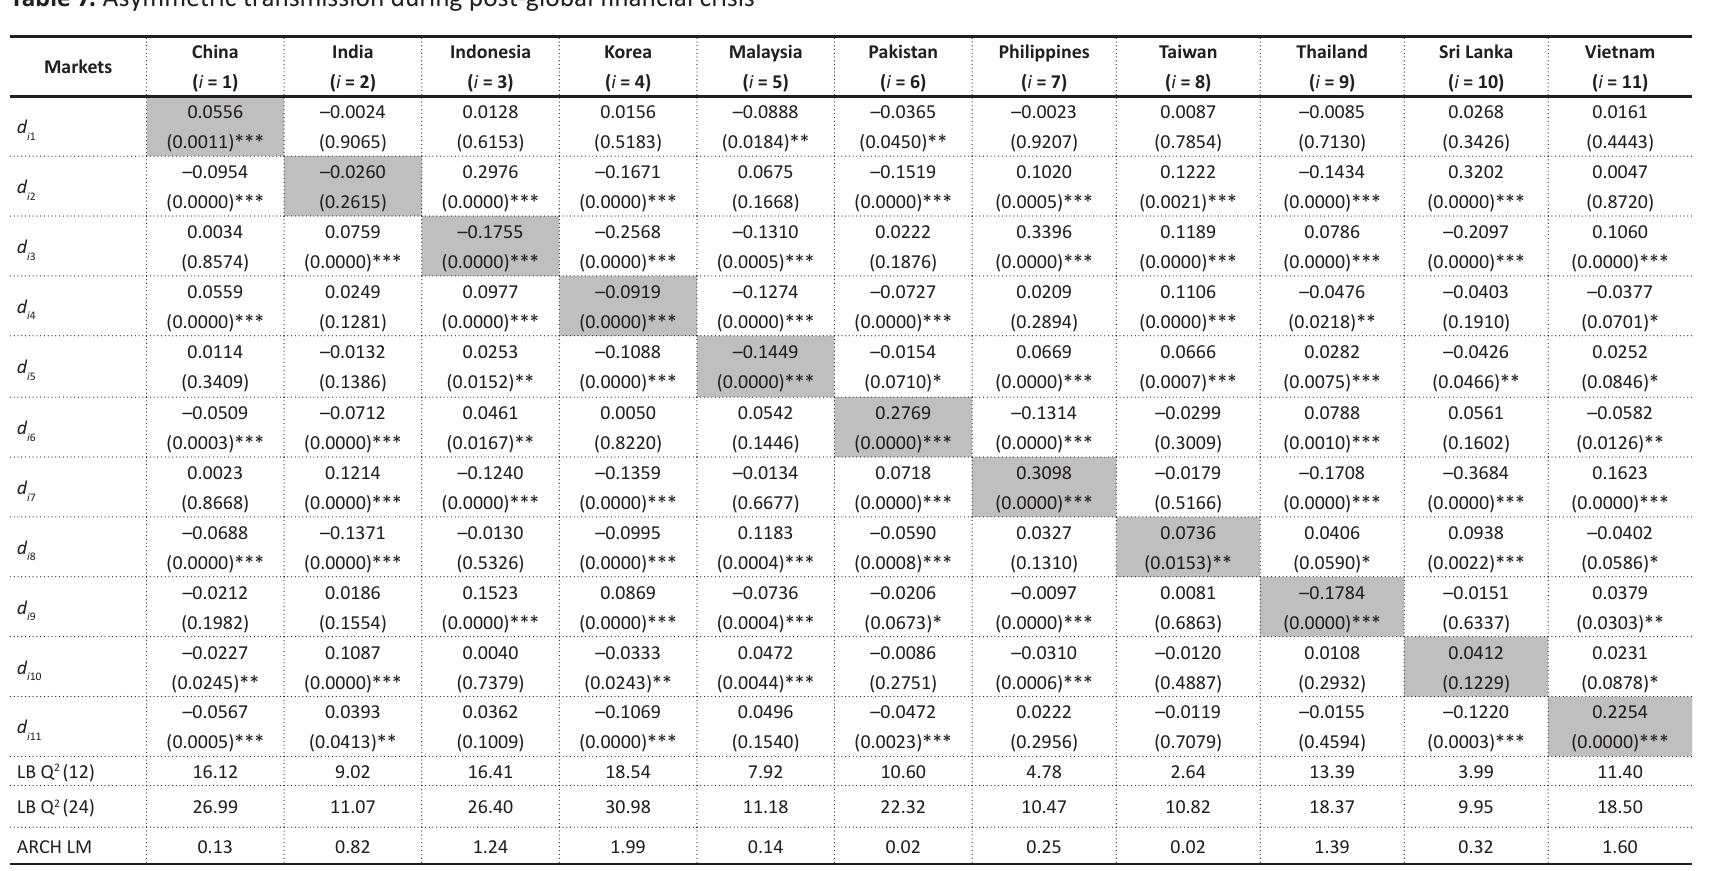
Table 7. Asymmetric transmission during post-global financial